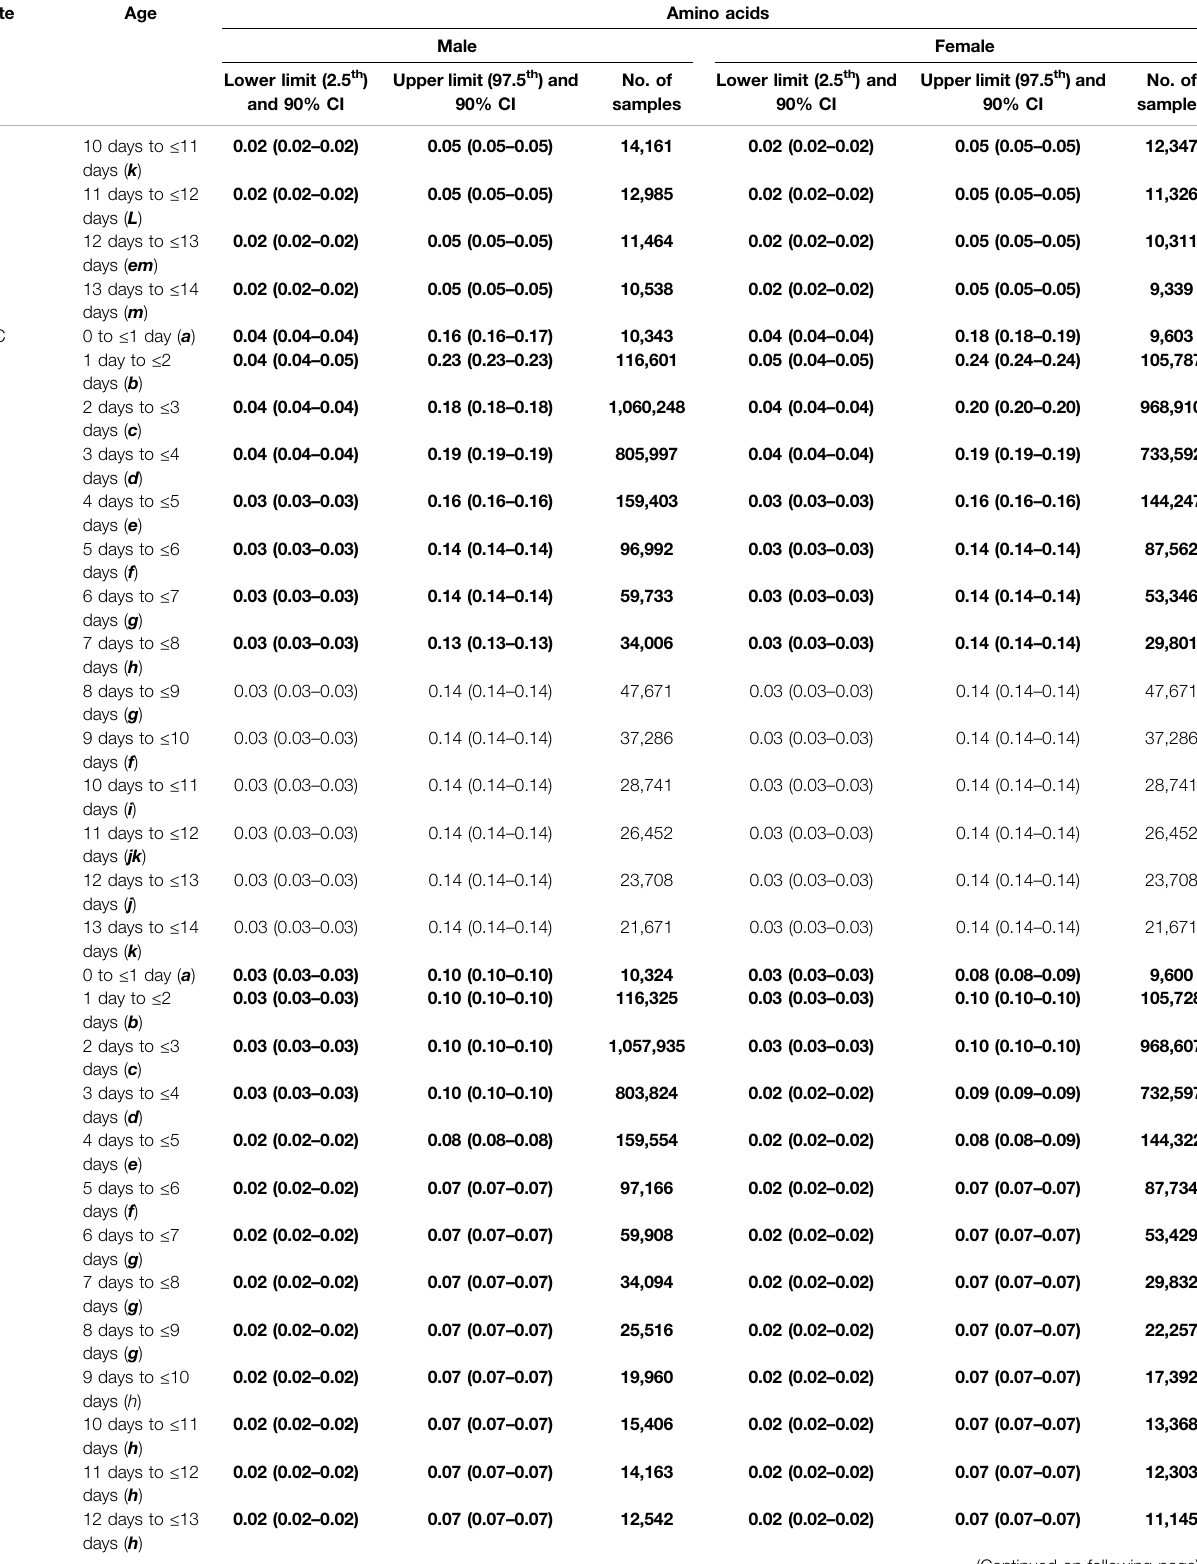
TABLE 2 | ( Continued ) The Reference intervals partitioned by each day and sex for 35 MS/MS NBS biomarkers ( μ